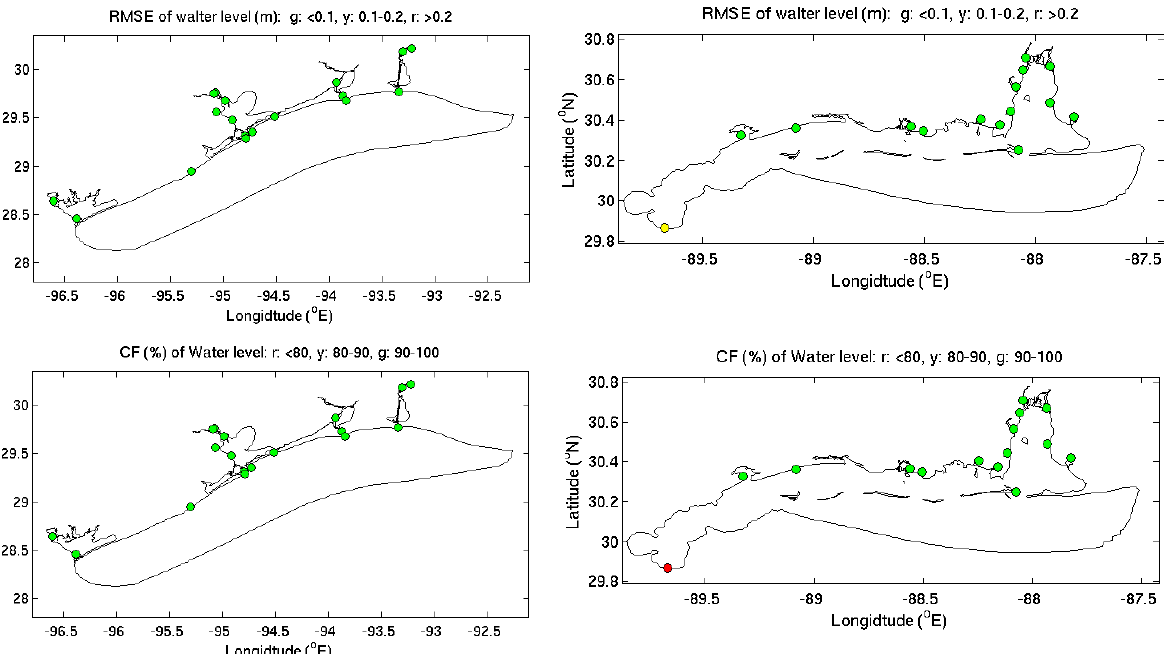
Figure 11. Hindcast water level RMSE and Central Frequency (CF) skill assessment summary map for NWGOFS (left column) and NEGOFS (right